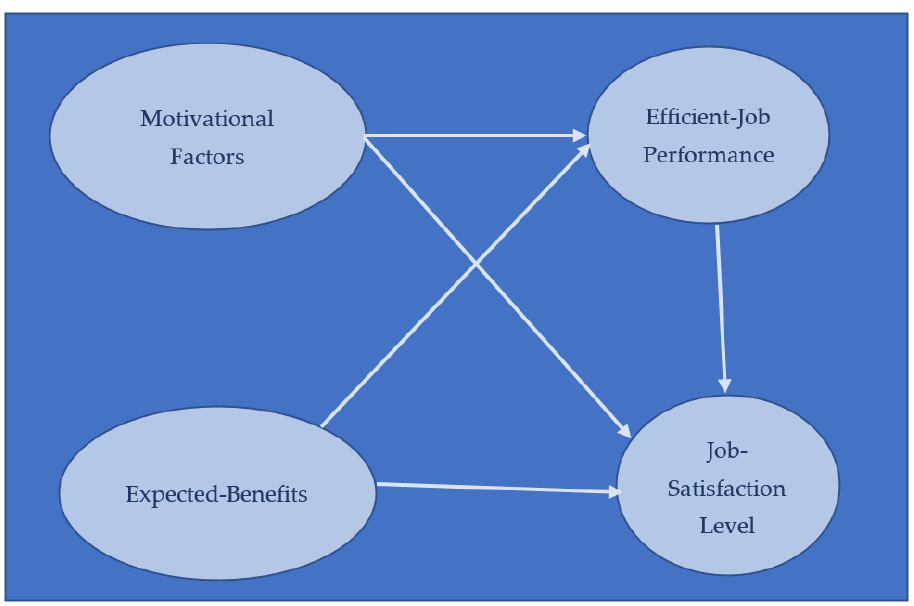
Figure 1. Theoretical framework of the study